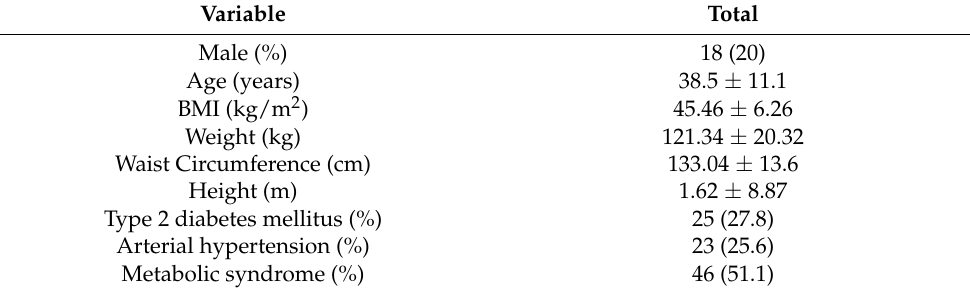
Table 1. Patient